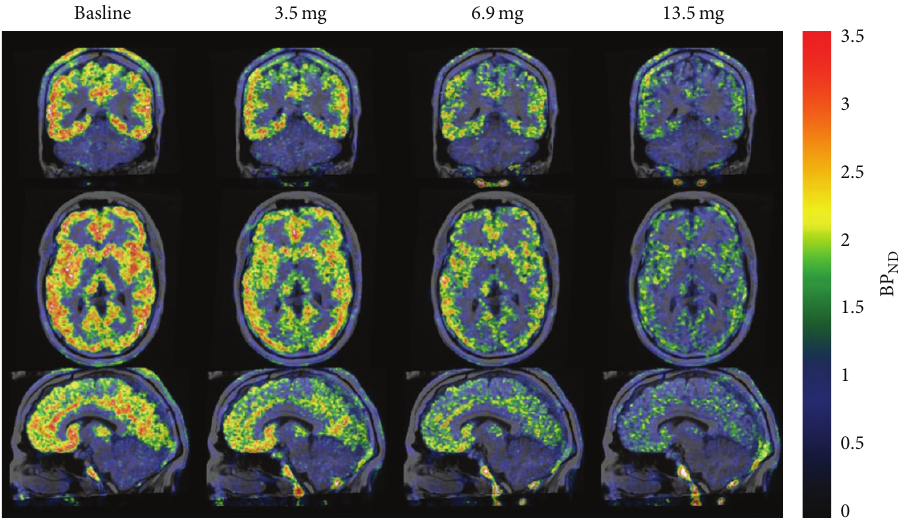
Figure 13: PET/MR images (0–63 min) showing the effect of AZD2066 on binding of [ 11 C]ABP688